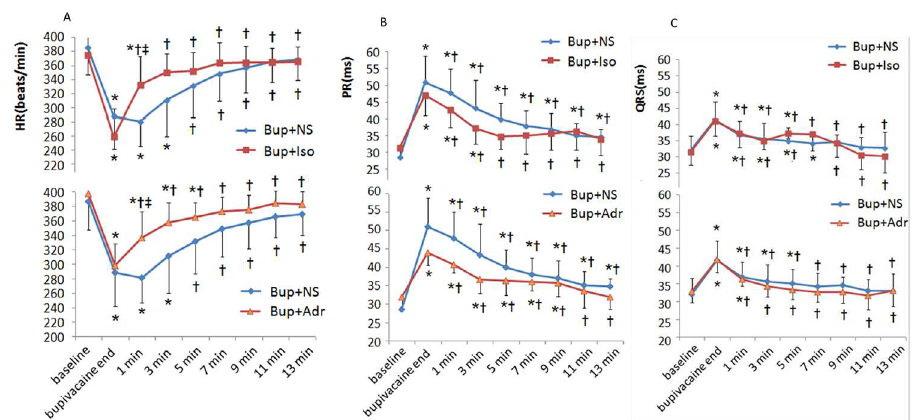
Fig 1. Chronotropic effect of β -adrenergic agonists in bupivacaine-intoxicated rats. (A) Bupivacaine significantly reduced HR, while adrenalin and isoprenalin restored HR. (B) Bupivacaine prolonged PR interval, while isoprenalin and adrenalin showed no effect on PR interval. (C) Bupivacaine widened QRS duration, while isoprenalin and adrenalin showed no improvement on QRS duration. (cid:3) P < 0.05, vs . baseline; † P < 0.05, vs , bupivacaine end; ‡ P < 0.05, vs . bupivacaine + NS